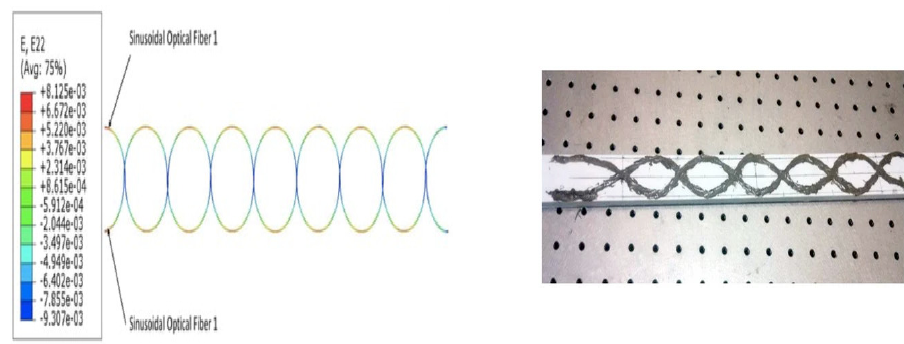
Figure 7. Dual-sinusoidal FOS placement embedded on a glass composite specimen along with strain measurements showing dual-sinusoidal FOS placement (placement in dual-sinusoidal mode, in phase opposition, provides coverage complementary to that of a single sinusoidal fiber) and a view of the specimen that was used for experimental validation.